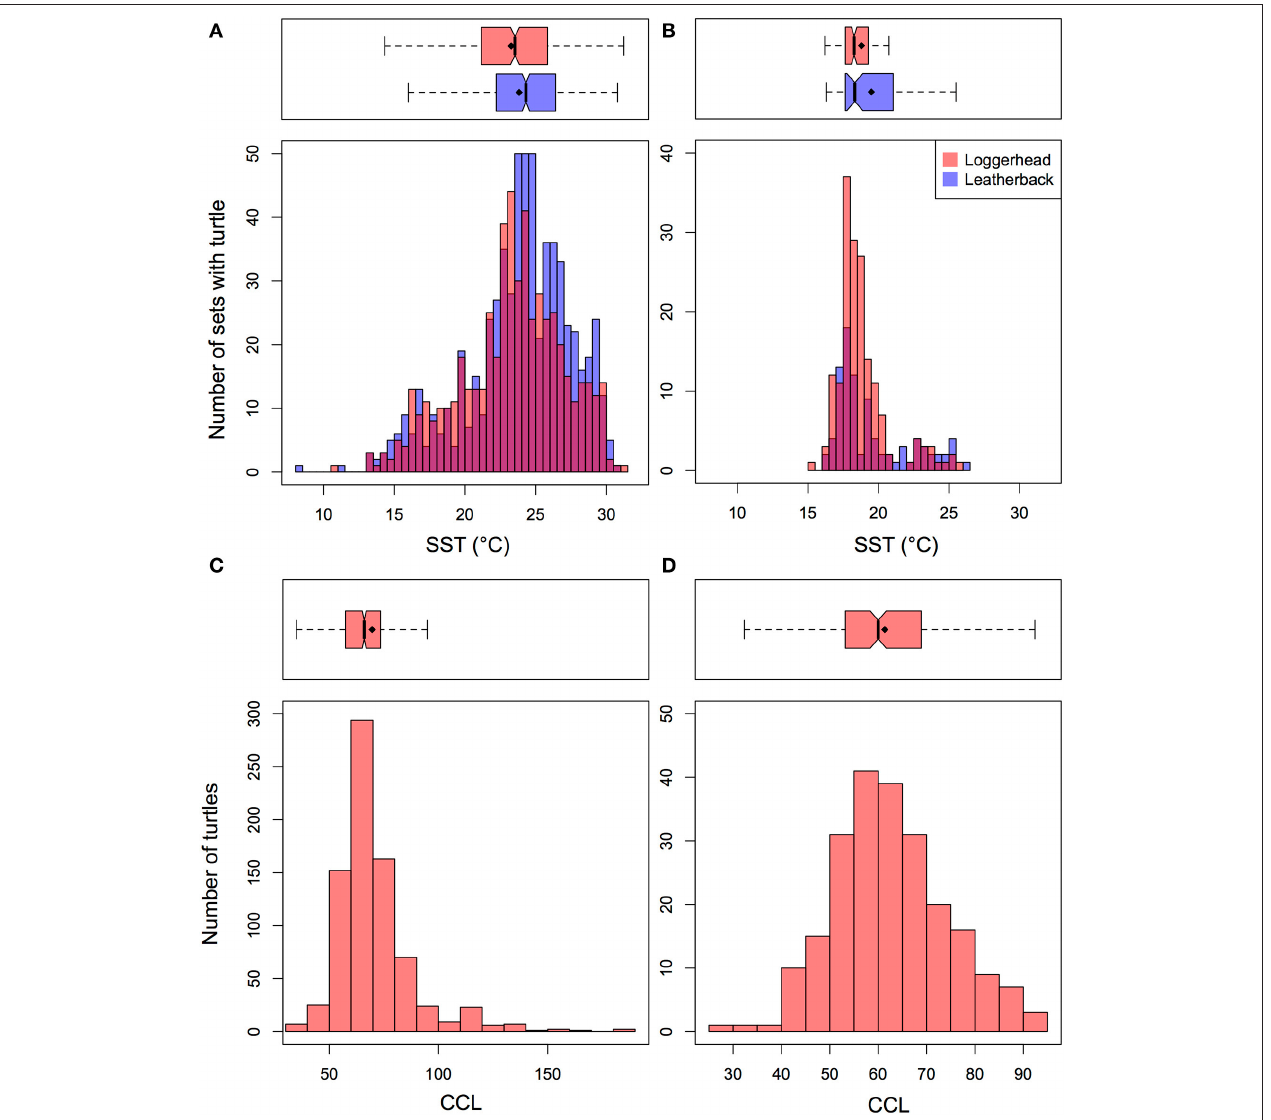
FIGURE 5 | Frequency of sets that caught loggerhead and leatherback turtles by set sea surface temperatures (SST) in the Atlantic (A) and Pacific (B) . Size frequency of loggerhead turtles captured in longline sets in the Atlantic (C) and Pacific (D) . Dots in paragraphs indicate mean and lines indicate median. Loggerhead turtle measurements in curved carapace length(CCL,